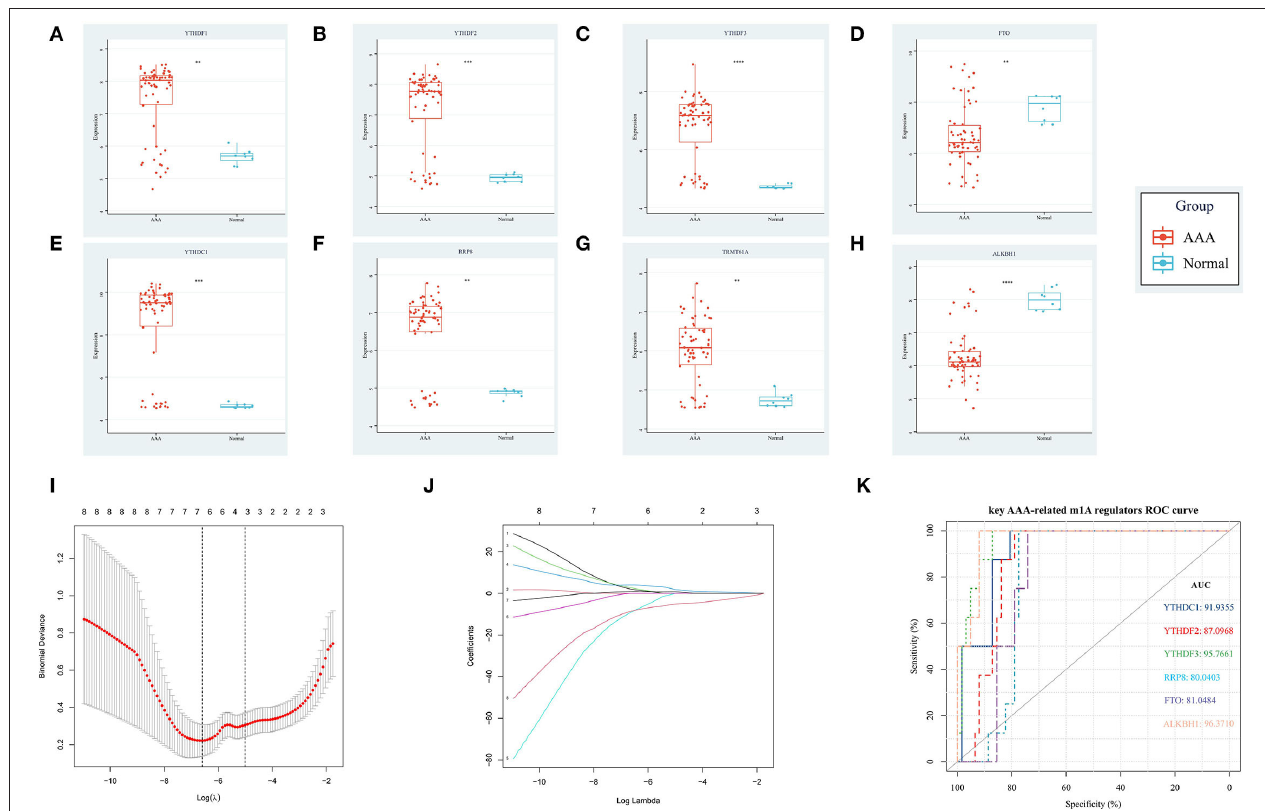
FIGURE 2 | The differential expression level and diagnostic value of DEMRGs in AAA. (A) The up-regulating expression level of YTHDF1 ; (B) The up-regulating expression level of YTHDF2 ; (C) The up-regulating expression level of YTHDF3 ; (D) The down-regulating expression level of FTO ; (E) The up-regulating expression level of YTHDC1 ; (F) The up-regulating expression level of RRP8 ; (G) The up-regulating expression level of TRMT61A ; (H) The down-regulating expression level of ALKBH1 ; (I) The LASSO regression model established by 8 DEMRGs; (J) The coefficients plot of 8 DEMRGs in the LASSO model; (K) The ROC curves with AUC values of 6 key AAA-related m1A